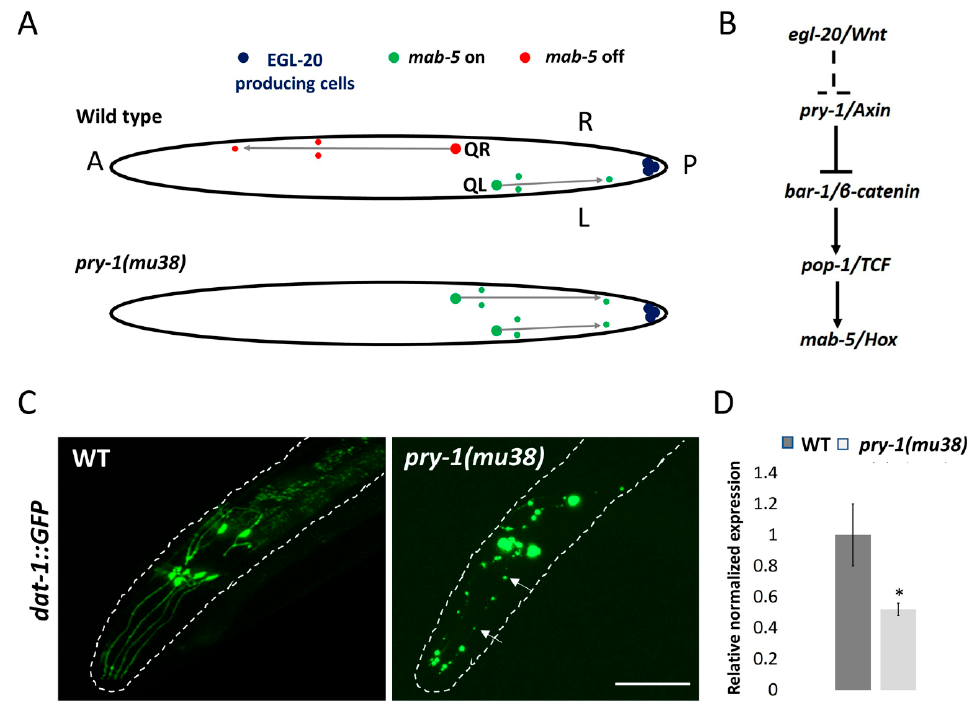
Figure 5. PRY-1 regulates neuronal development in C. elegans . ( A ) EGL-20/WNT signaling